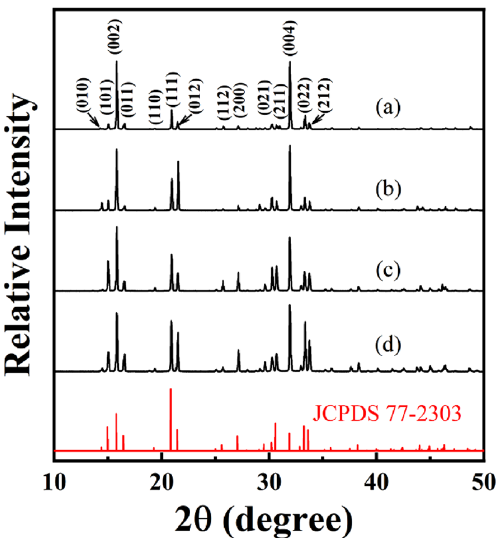
Figure 1. Representative XRD patterns of the samples obtained at a mineralization time of 3 ( a ), 5 ( b ), 8 ( c ), or 15 d ( d